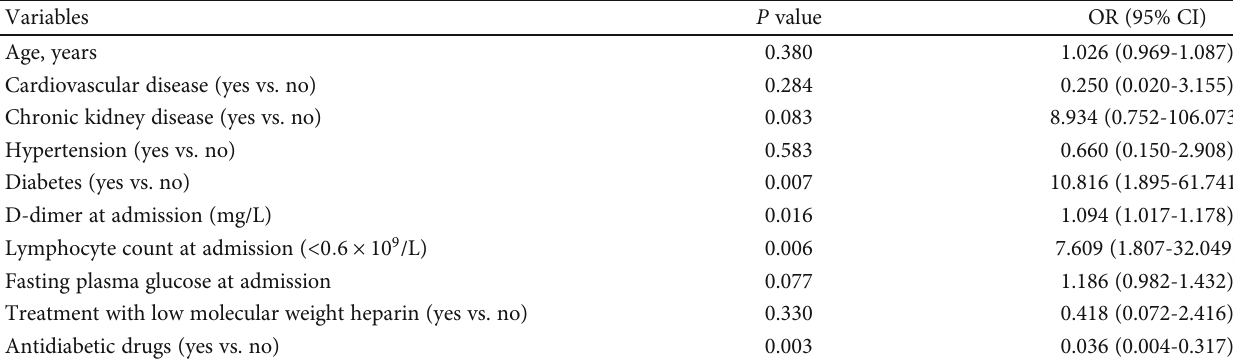
Table 3: Multivariable analysis of independent risk factors associated with in-hospital death.